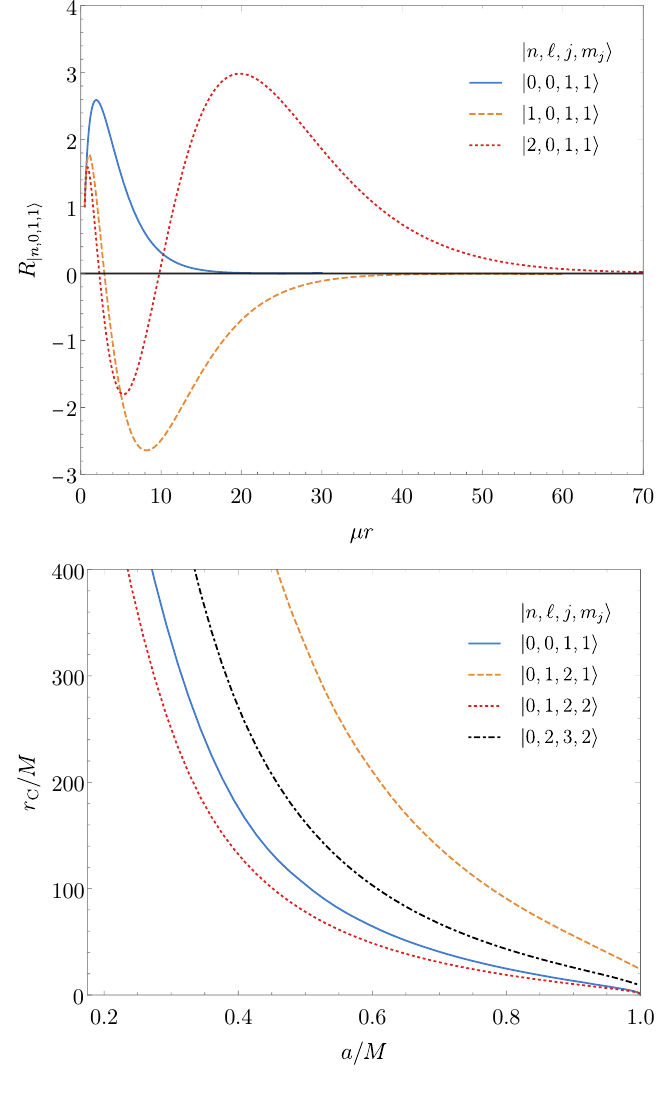
Figure 2 . (Top panel) Radial pro(cid:12)les of the bound states I , II and III in (cid:12)gure 1 (bottom panel), characterized by (cid:22)r H = 0 : 5. The radial functions are normalized so that R ( r H ) = 1. The cloud is especially close to the event horizon when n = 0. (Bottom panel) Radius of di(cid:11)erent stationary vector clouds with n = 0, as a function of a=M